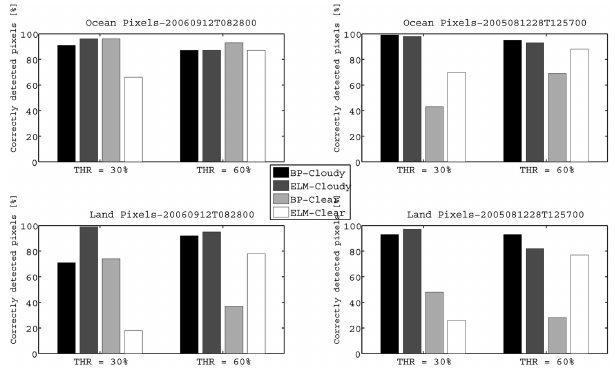
Fig. 3. Performance of backpropagation and extreme learning ma- chine in predicting cloud fraction for divided land and ocean pixels.